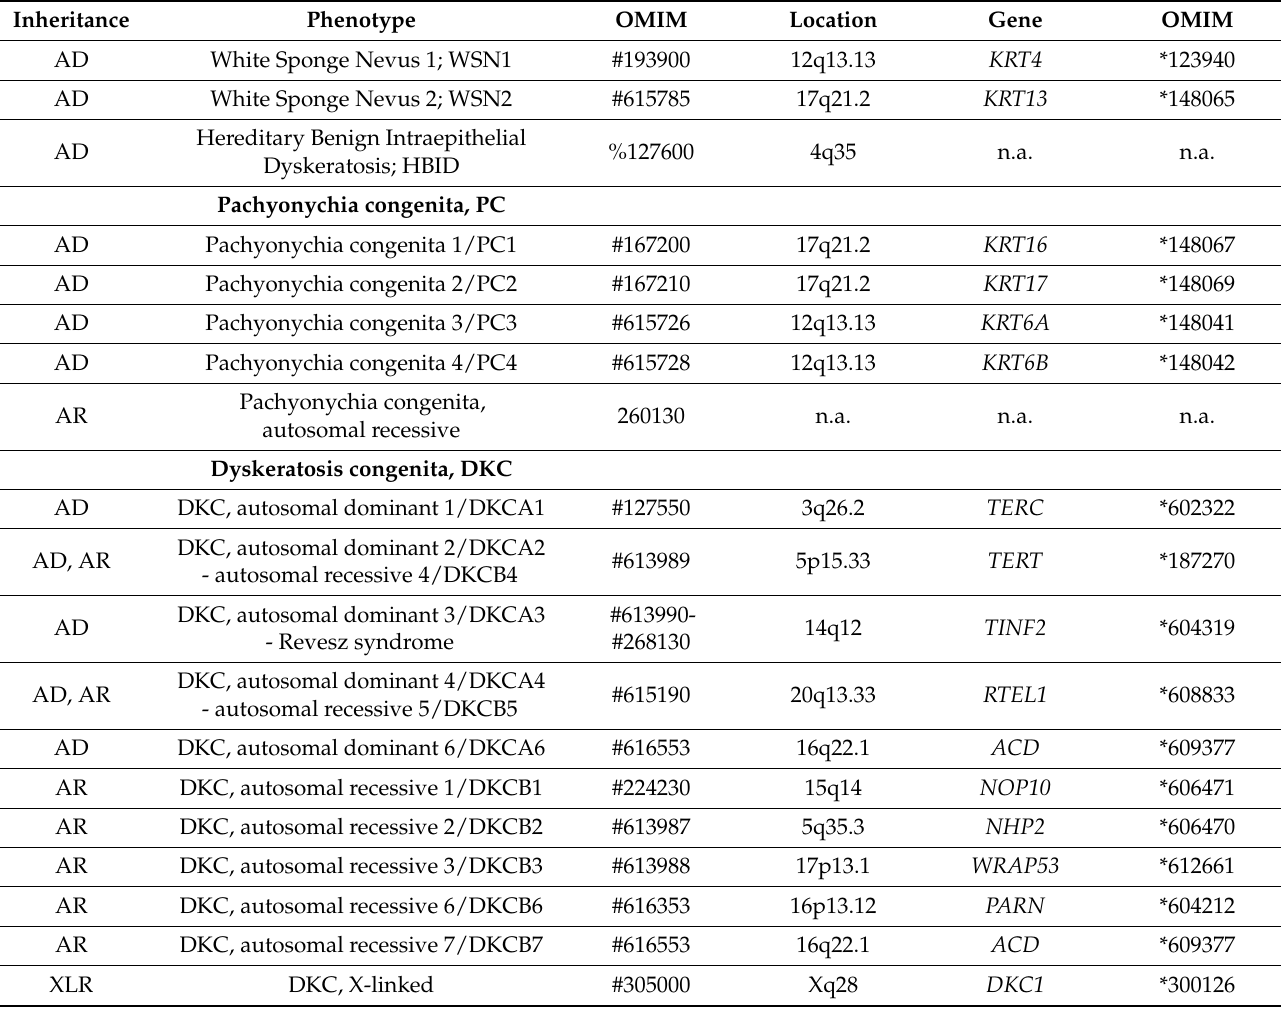
Table 1. Differential diagnosis of White Sponge Nevus (WSN) with other genodermatoses with white oral lesions. For each condition (Phenotype), the inheritance patter is indicated (AD: Autosomal Dominant; AR: Autosomal Recessive; XLR: X-linked Recessive; n.a.: not available). When the causative genes are known, they are indicated along their chromosomal location. OMIM stands for Online Mendelian Inheritance in Man, a catalog of human genes with monogenic inheritance (www.omim.org accessed on 14 April